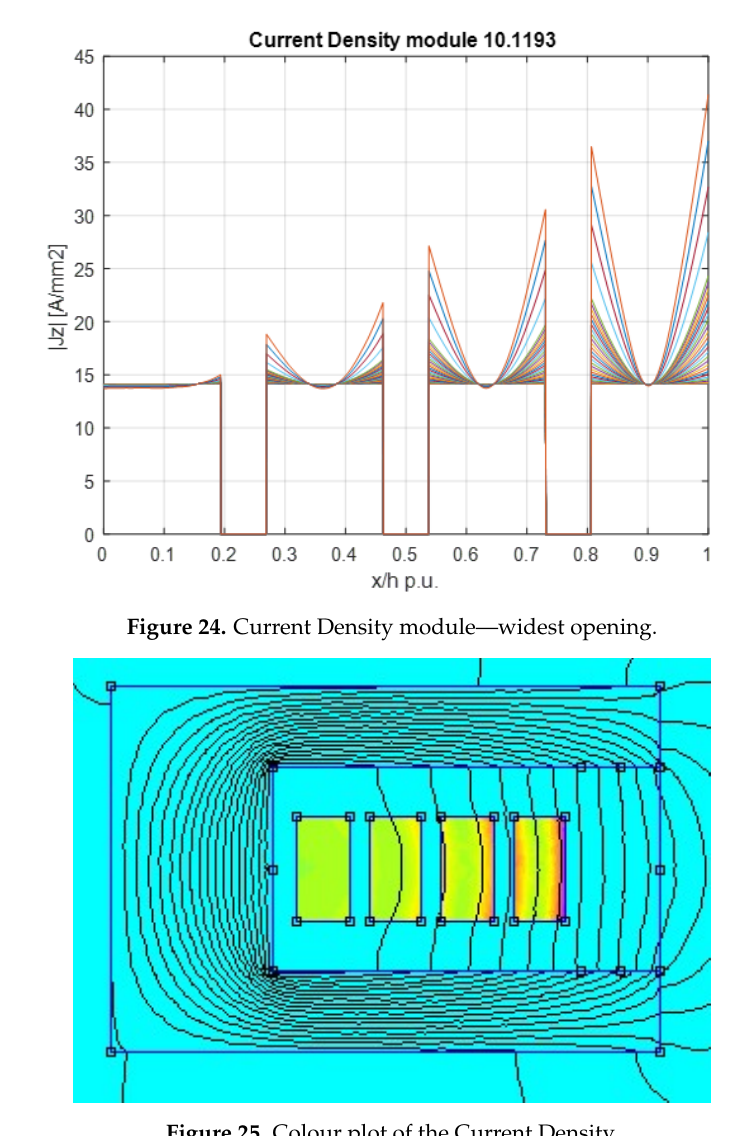
Figure 25. Colour plot of the Current